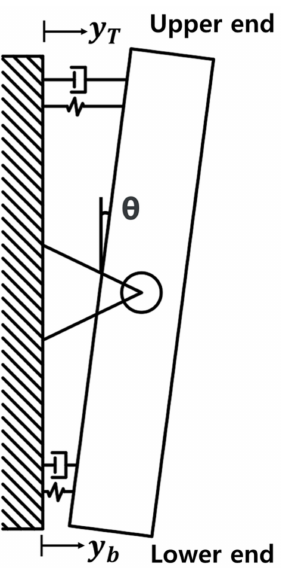
Figure 1. Mechanical behavior of